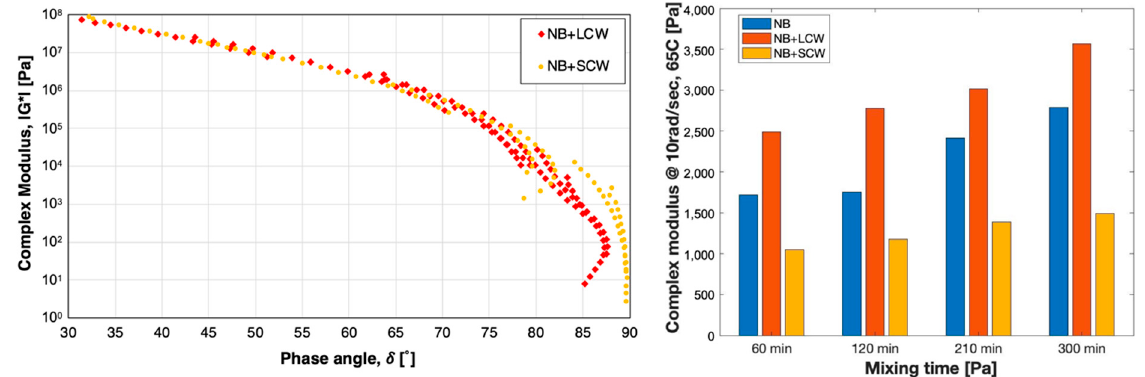
Figure 4. Black diagrams and complex modulus at 65 °C and 10 rad/sec after 5 h of blending.